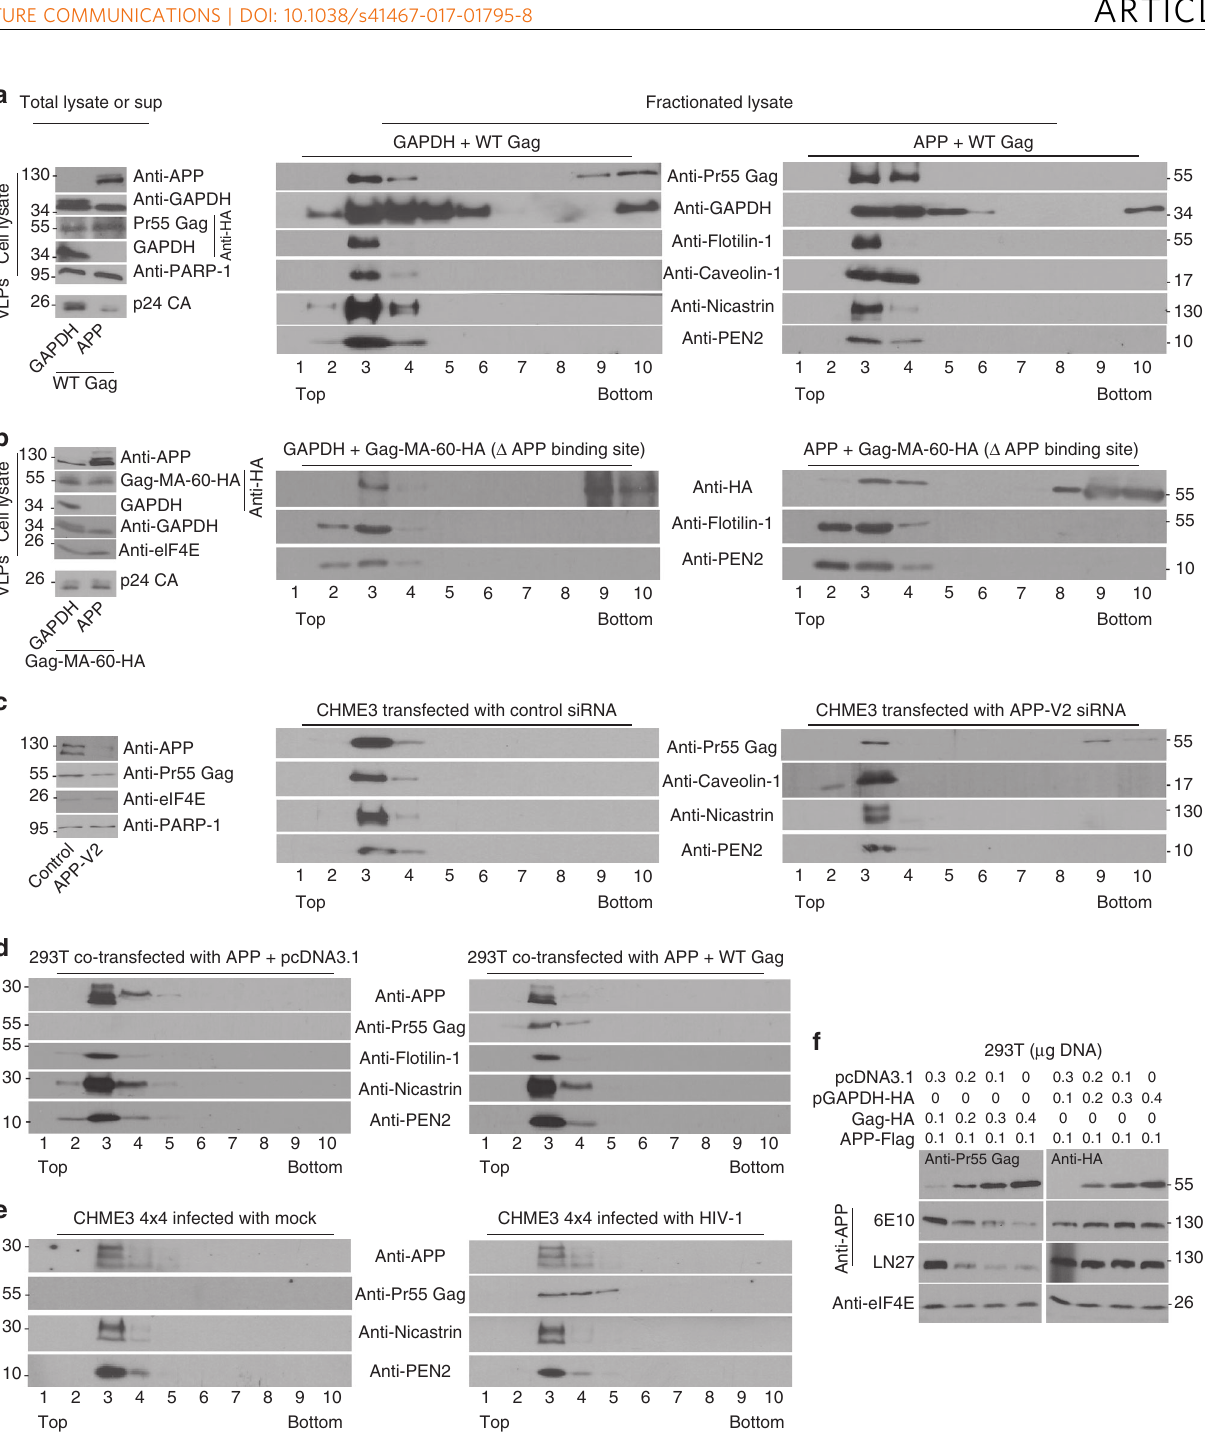
NATURE COMMUNICATIONS | 8:1522 | DOI: 10.1038/s41467-017-01795-8 |